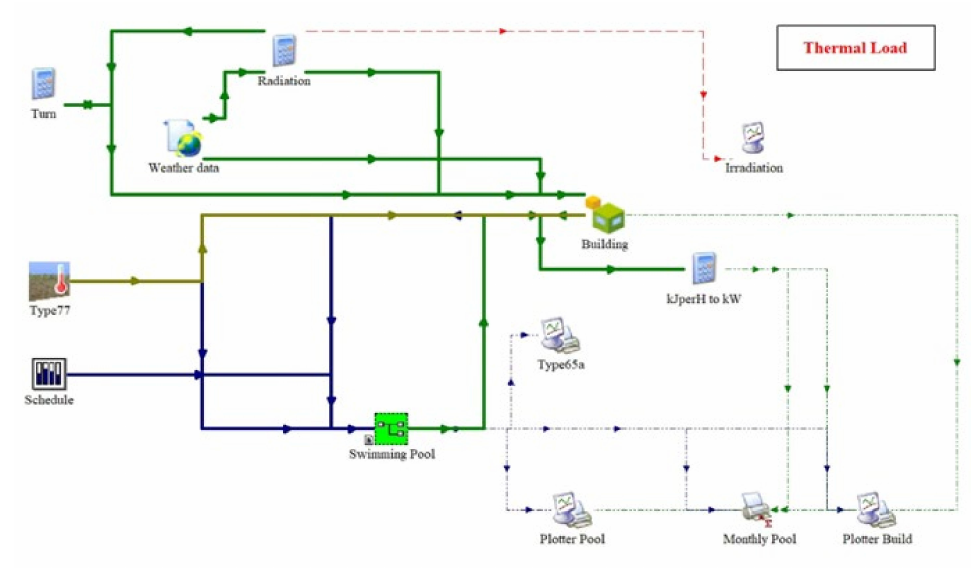
Figure 7. Interface of the building thermal load simulation macro in the TRNSYS